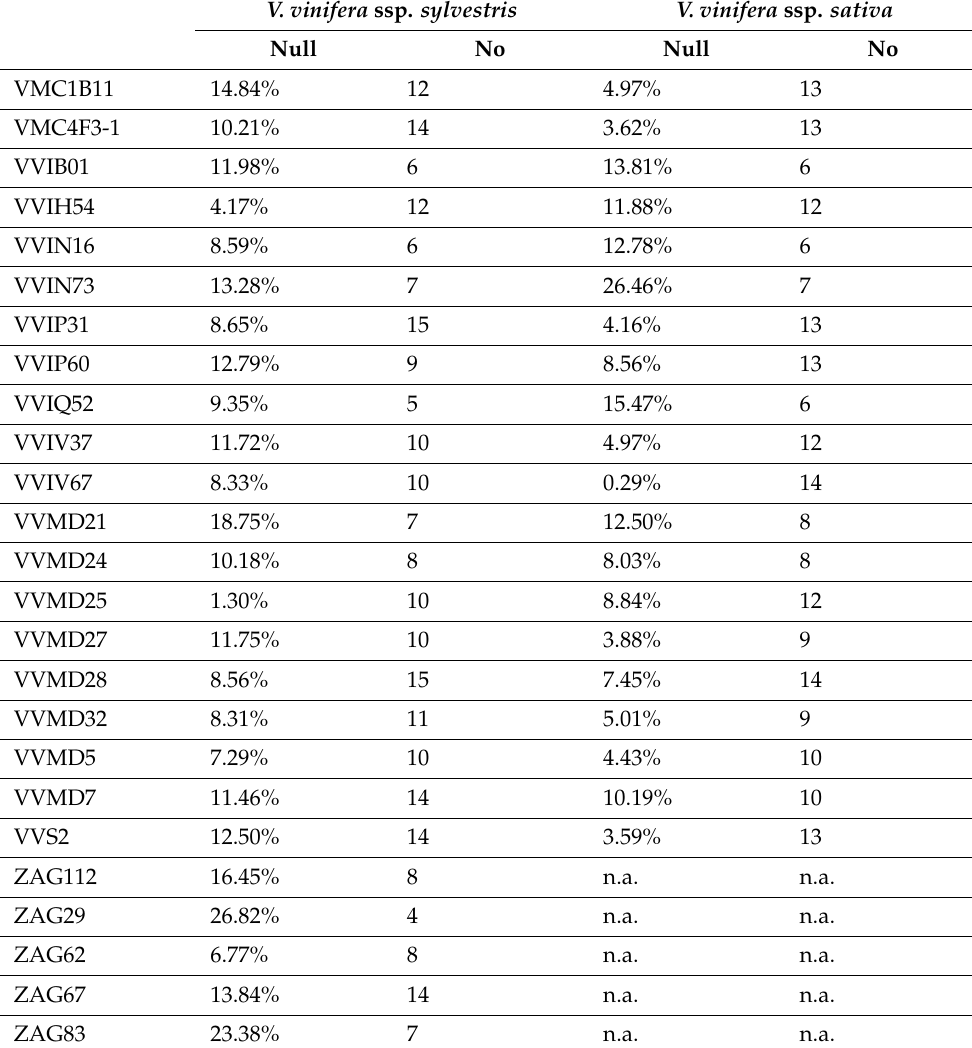
Table 1. Ratio of null alleles (Null) and number of alleles (No) in Vitis vinifera L. ssp. sylvestris populations in 25, and among Vitis vinifera L. ssp. sativa cultivars in 20 SSR loci respectively, calculated by MolMarker [16] from the data published by De Andres et al.